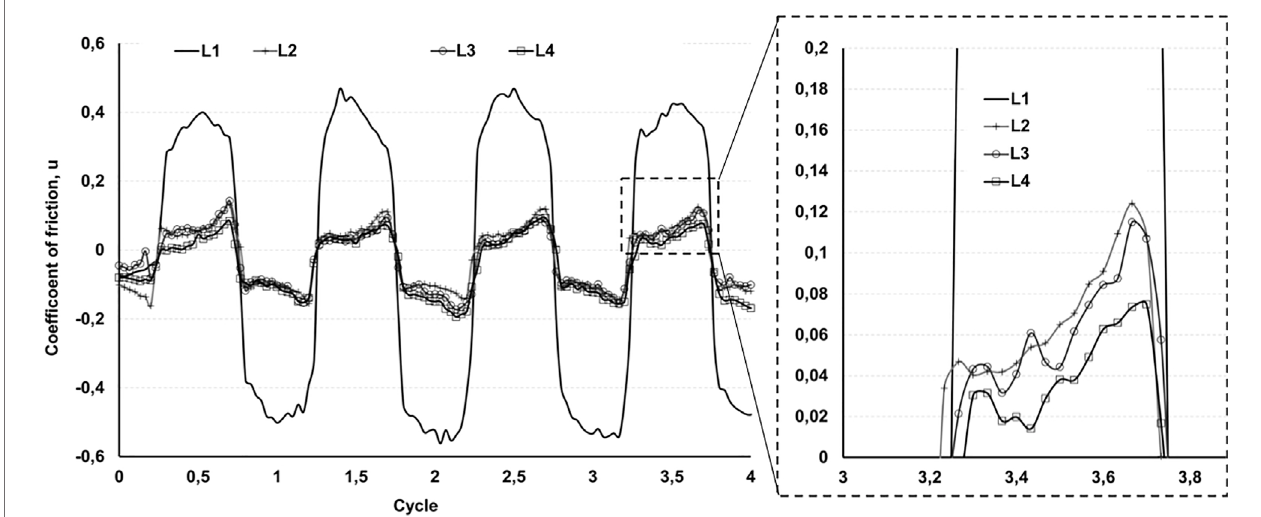
FIGURE 6 | Friction coef fi cient at the beginning of sliding test showing the decrease the friction of the tribo-pair due to the presence of additives in the lubricant.